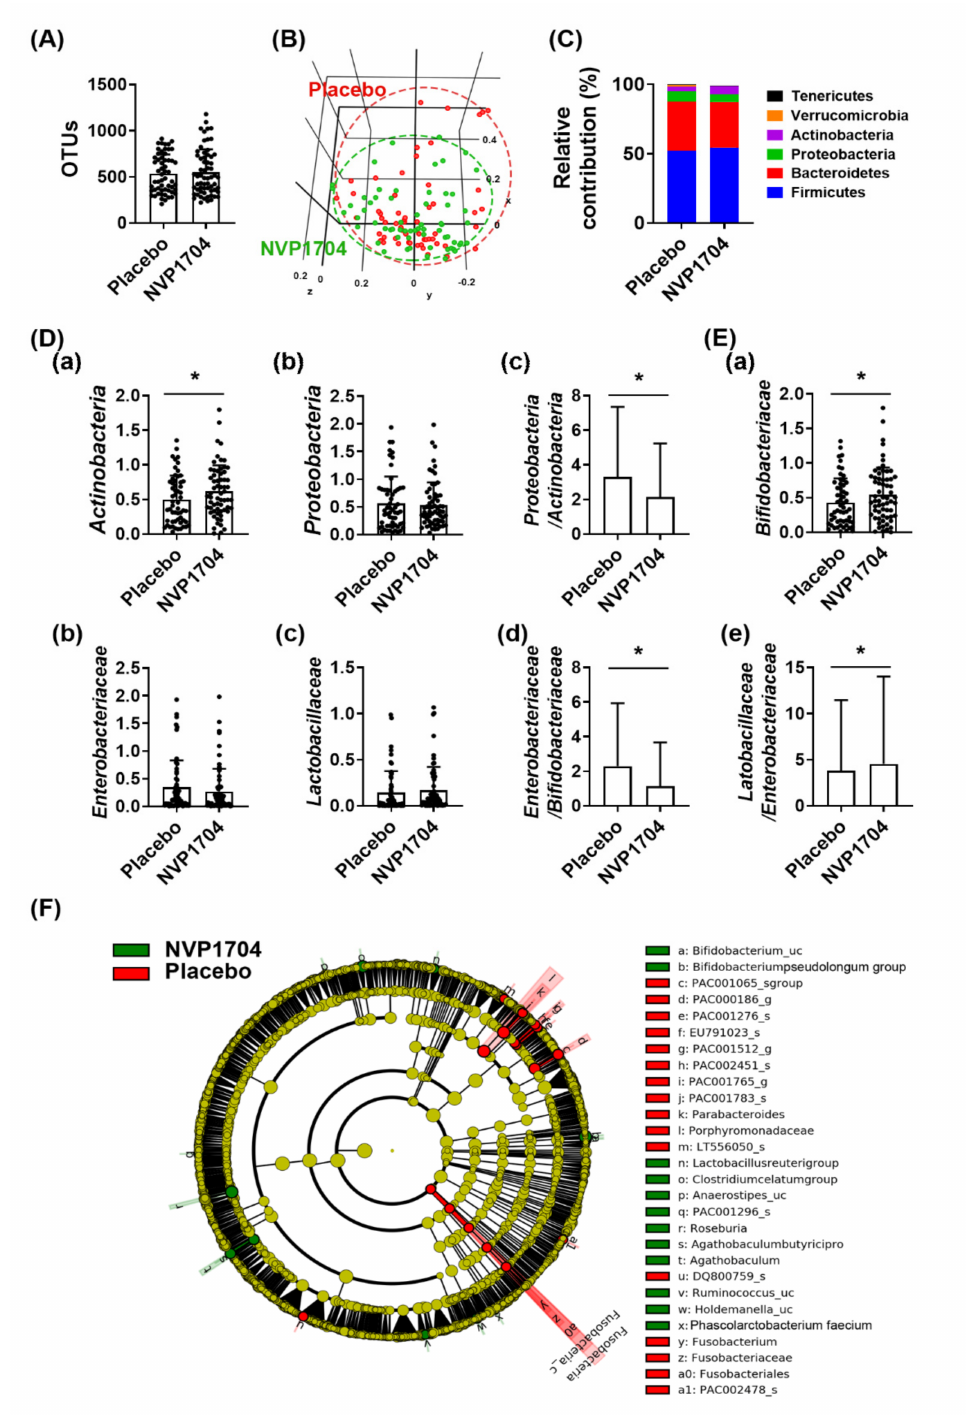
Figure 6. Effects of NVP-1704 on the gut microbiota composition. Effect on the α -diversity (estimated operational taxonomic units, OTUs) ( A ) and β -diversity (principal coordinate analysis [PCoA] plot based on Jansen-Shannon) ( B ). Effects on gut bacteria composition at the phylum ( C ) and cladogram ( F ) generated by linear discriminant analysis effect size indicating significant differences in gut microbial abundances. ( D ) Effect on the Actinobacteria ( a ) and Proteobacteria populations ( b ) and their ratio ( c ) at the phylum level. ( E ) Effect on the Bifidobacteriaceae ( a ), Enterobacteriaceae ( b ) and Lactobacillaceae populations ( c ) and as their ratio, Enterobacteria per Bifidobacteriaceae ( d ) and Lactobacillaceae per Enterobacteriaceae ( e ) at the family level. The composition of Actinobacteria, Proteobacteria, Bifidobacteriaceae, Enterobacteriaceae, and Lactobacillaceae populations was indicated as log (composition percent + 1). Data indicate mean ± standard deviation. * The significance was analyzed by one-tailed Mann–Whitney test ( p <